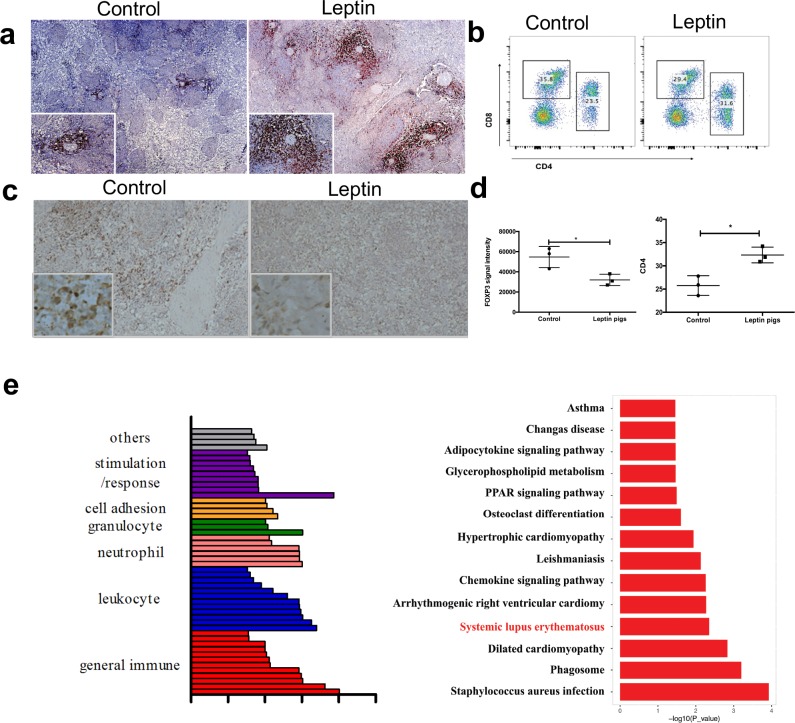
Effects of leptin on the immune system.Sections of spleen tissues from both control and transgenic leptin pigs were probed with (a) CD4 and (b) FOXP3 antibodies. (c) The ratio of CD4+/CD8+ cells in PBMCs was detected by flow cytometric analysis. (d) Five random scopes were captured for statistical analysis. The mean level of Foxp3 to CD4 signal intensity ratio and standard error bars are presented (n = 3 per group). (e) RNA-seq was performed on PBMCs to determine the transcriptome change in the transgenic leptin pigs (n = 3 per group). Summary of gene-significant differences in KEGG pathways. Histogram of the GO classifications of gene-significant differences. *p < 0.05, two-tailed Student t test for d,e. Data are presented as mean ± SEM. Numerical values are provided in S1 Data. GO, gene ontology; KEGG, Kyoto Encyclopedia of Genes and Genomes; PBMC, peripheral blood mononuclear cell; PPAR, Peroxisome proliferator-activated receptors; RNA-seq, RNA sequencing.